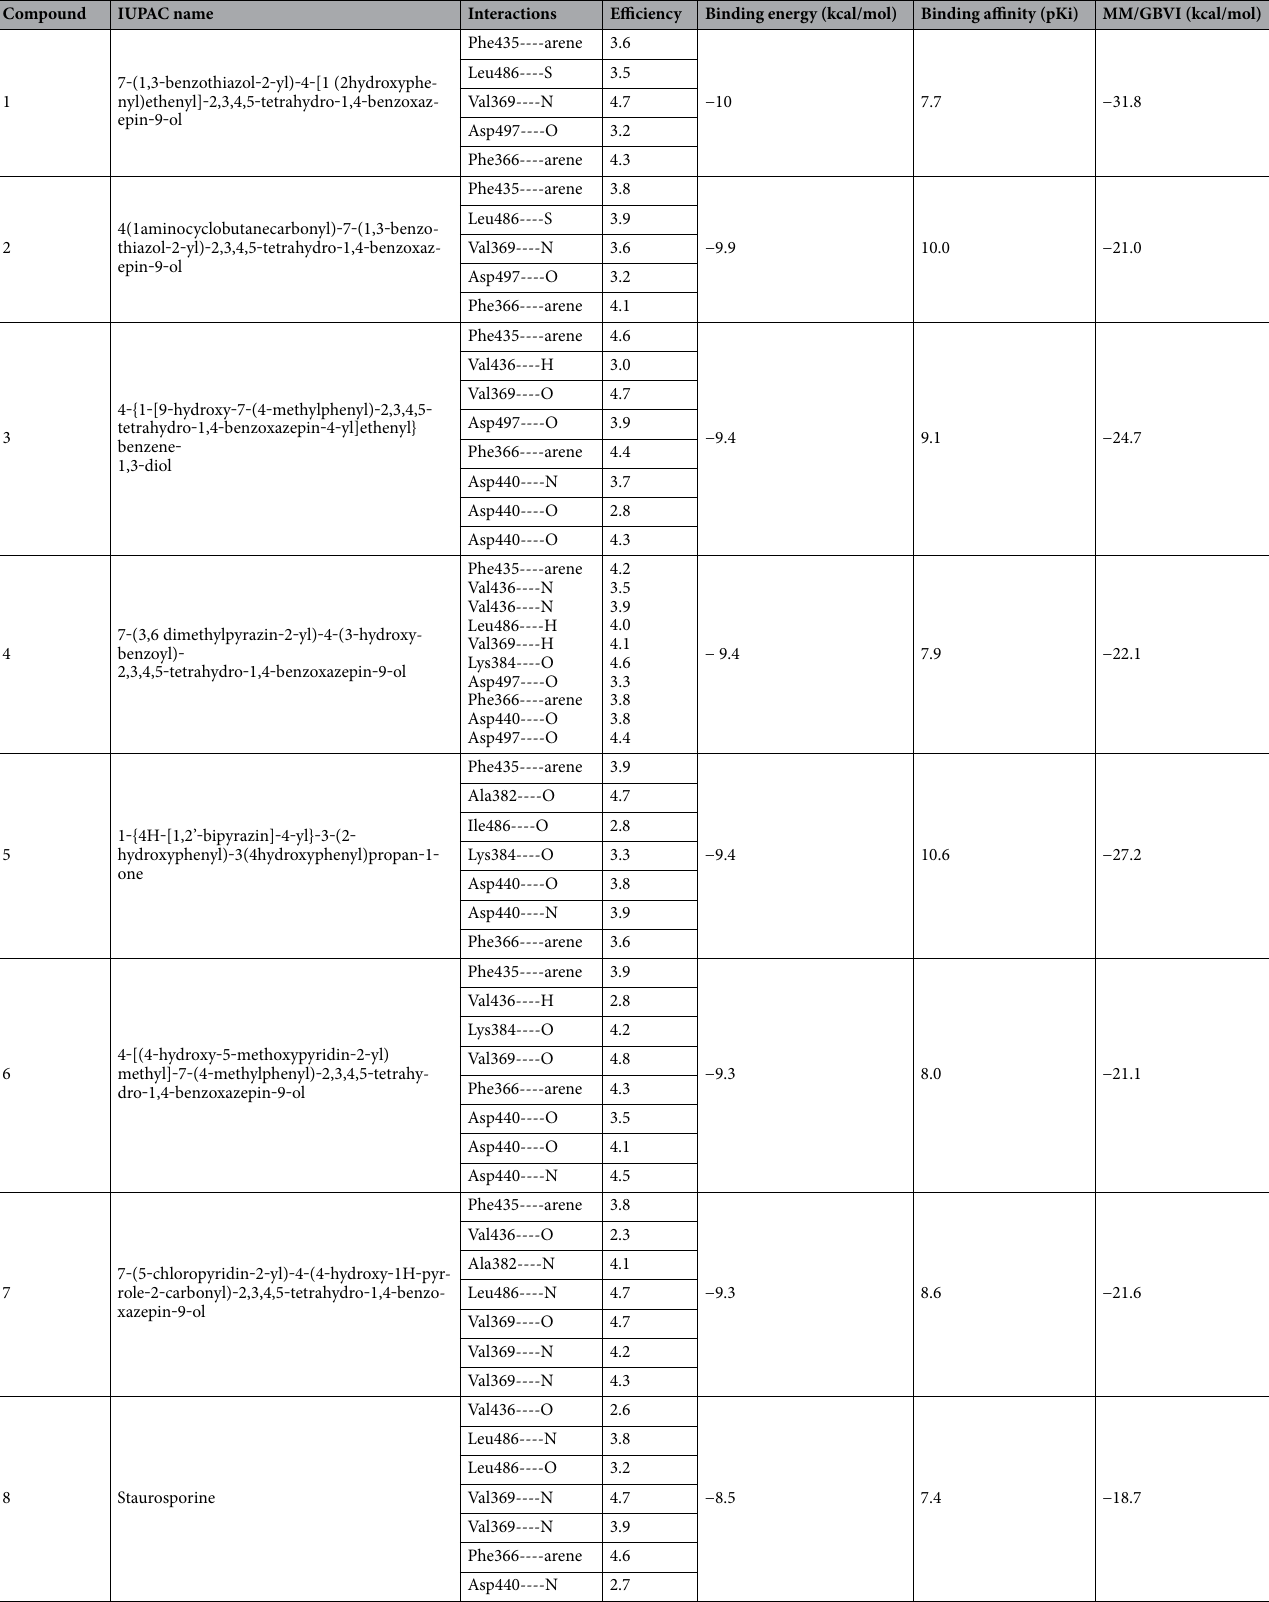
Table 3. 2D structures, IUPAC name, binding interactions, efficiency, binding energy, binding affinity, and MM/GBVI of the best lead molecules of